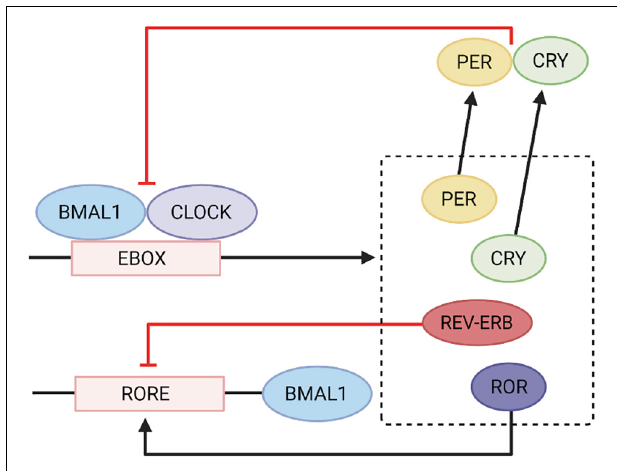
FIGURE 1 | Circadian gene transcription and translational feedback loop. CLOCK and BMAL1 genes heterodimerise and bind to the E-box element on PER , CRY , ROR , and REV-ERBA genes which activates transcription. CRY and PER gene products inhibit CLOCK and BMAL1 gene expression. REV-ERB inhibits the RORE element on BMAL1 genes and ROR activates it to increase BMAL1 gene expression. Adapted from Wang et al. (2014) International Journal of Molecular Sciences. Image created using